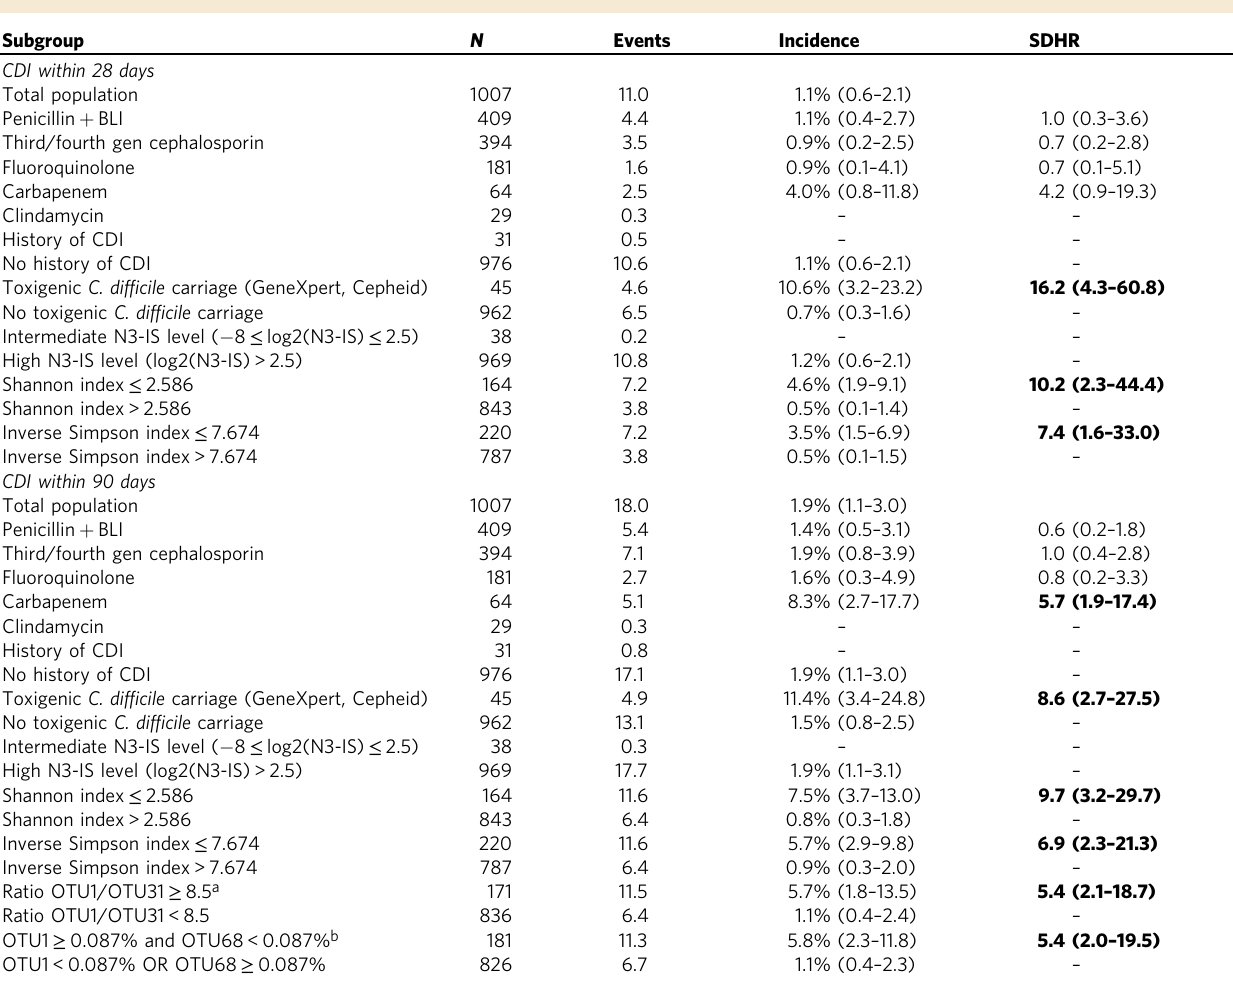
Table 3 Cumulative incidence of CDI within 28 and 90